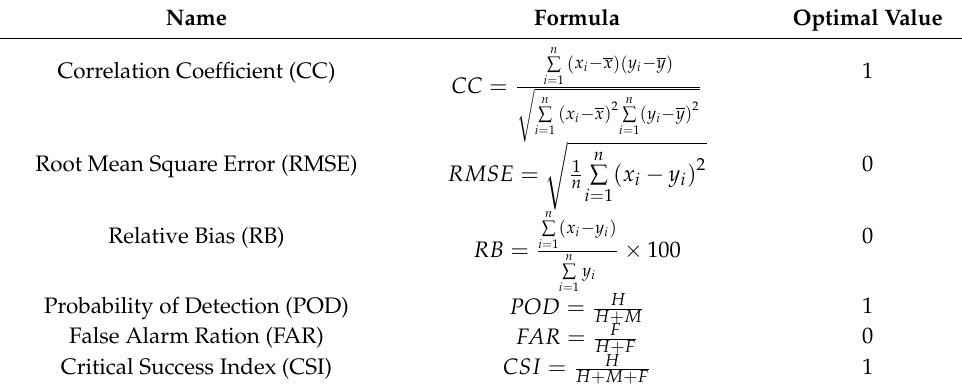
Table 2. Continuous and categorical verification